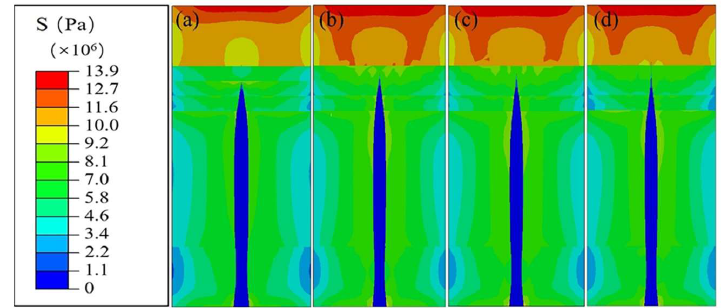
Figure 10. Stress distribution cloud after fracturing under different Young’s modulus conditions: ( a )